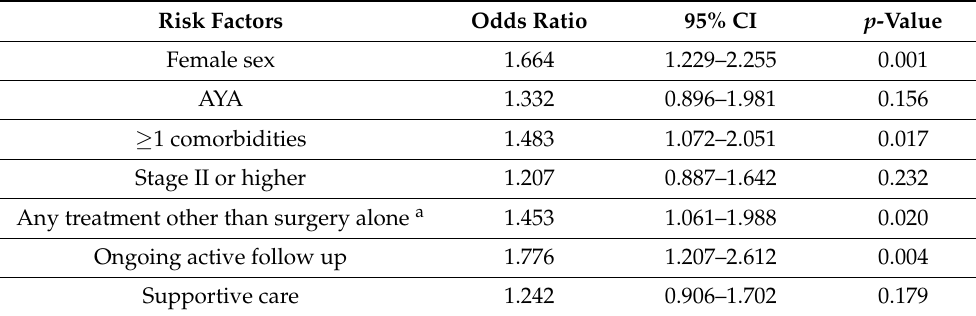
Table 4. Multivariate logistic regression analysis for factors associated with high